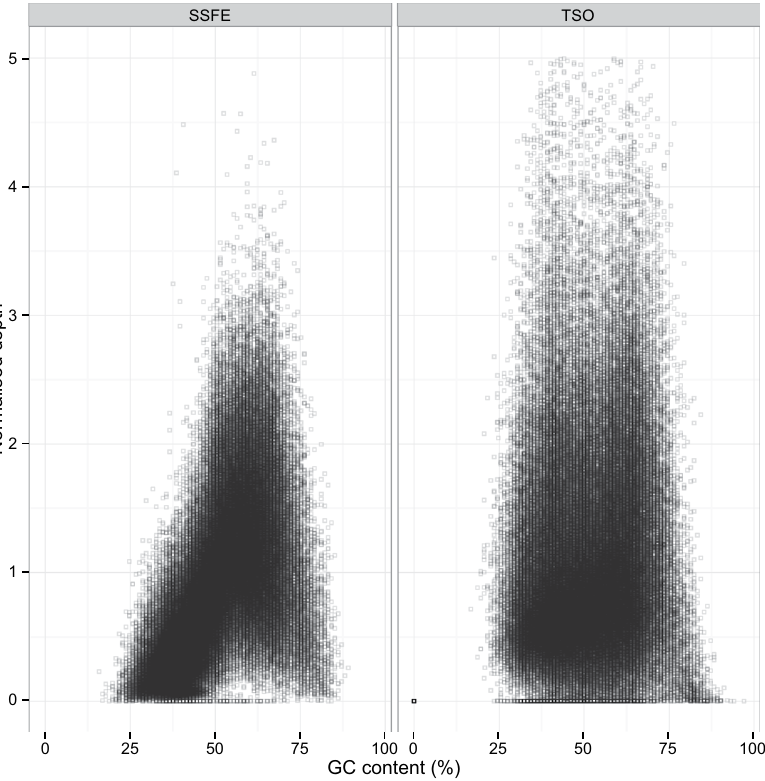
Figure 2. Capture biases for the two kits. The degree of GC bias seen is greater for the SSFE data (r 2 = 0.56 vs . r 2 = 0.09 for SSFE and TSO respectively, p < 2.2 × 10 − 16 for both, Pearson’s correlation).